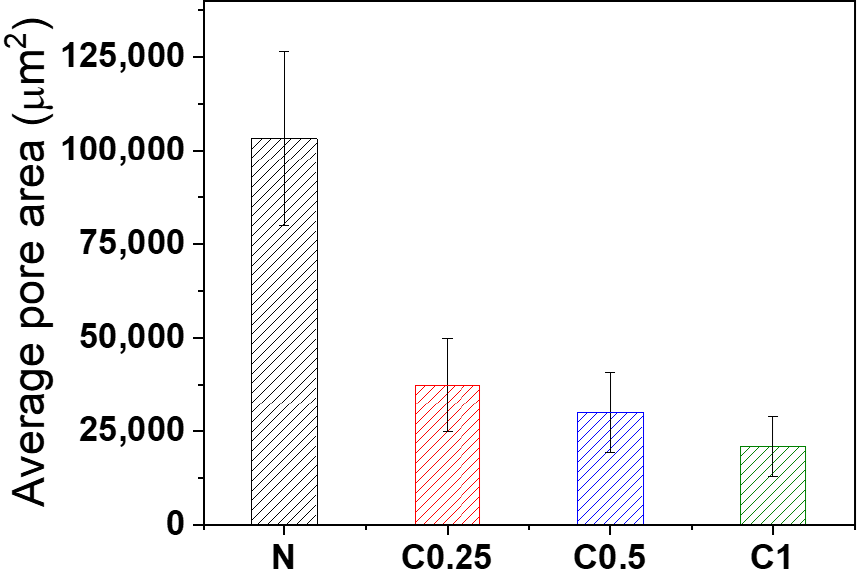
Figure 6. The average cell size of foam with different CNF contents compared with neat foam.